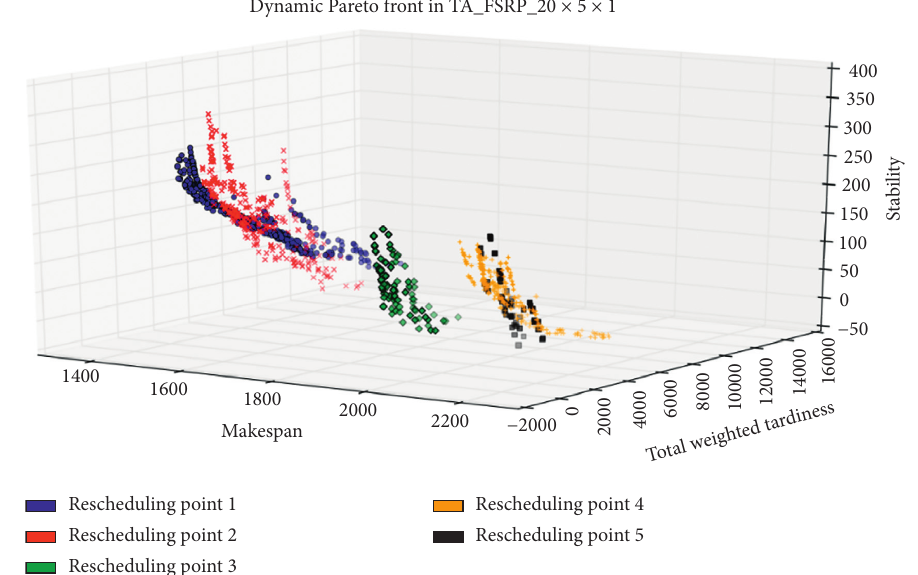
Figure 6: RIPG Pareto front in